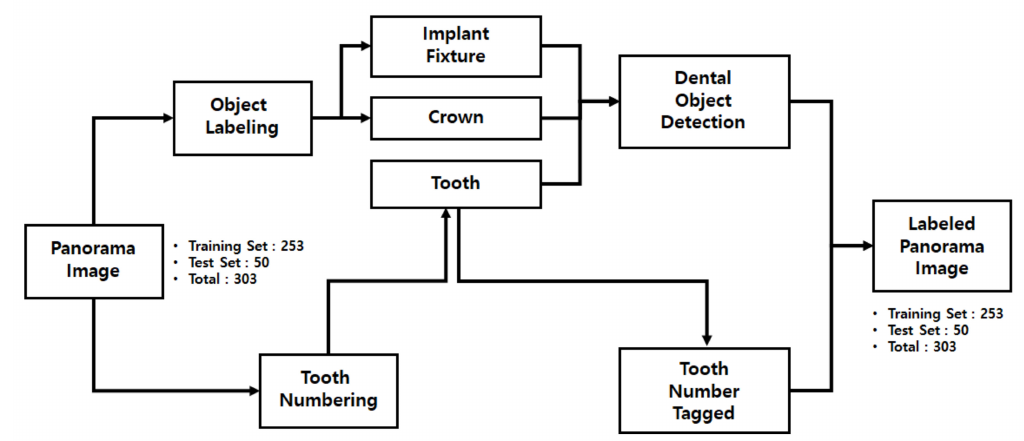
Figure 5. DPR labeling